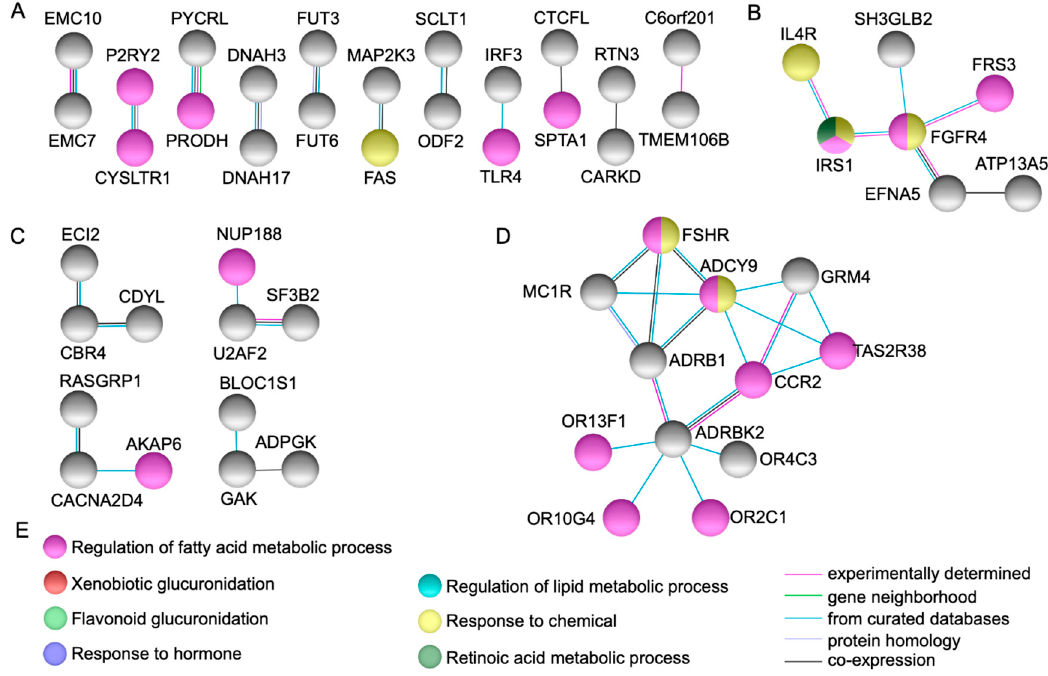
Figure 2. Network modeling from protein-protein interactions. Figures ( A ) and ( C ) show several direct protein-protein dyads and triads. Figures ( B ) and ( D ) show high connectivity and direct protein-protein interactions via several partners in genes ADCY9 and FGFR4 . Figure ( E ) depicts the biological processes identified in the networks.